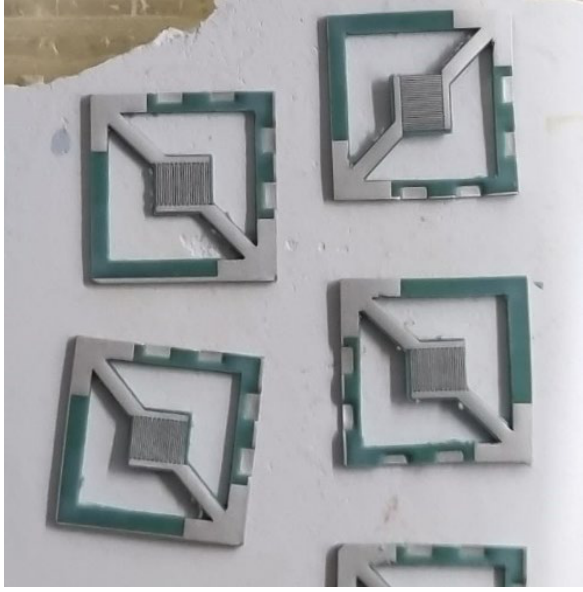
Figure 4. Sensor prototypes after firing.